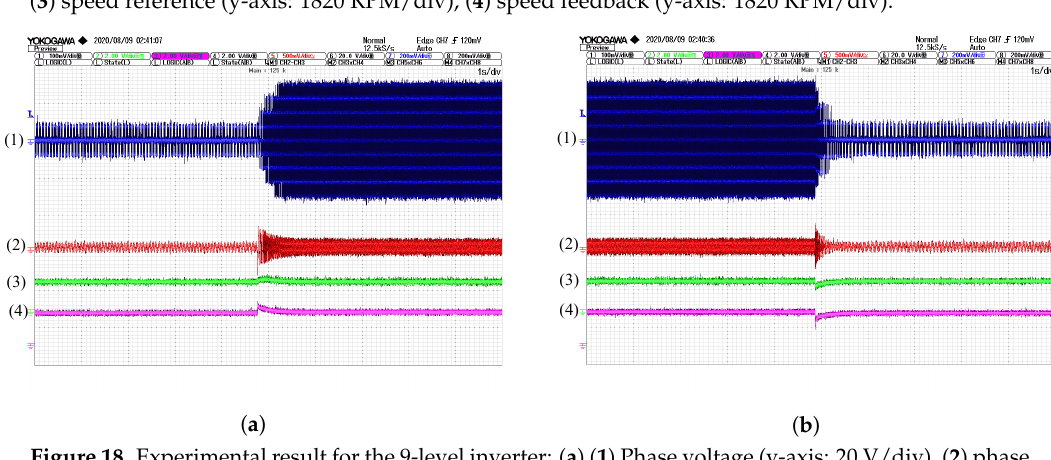
Figure 18. Experimental result for the 9-level inverter: ( a ) ( 1 ) Phase voltage (y-axis: 20 V/div), ( 2 ) phase current (y-axis: 5 A/div), ( 3 ) i d (y-axis: A/div), ( 4 ) i q (y-axis: A/div). ( b ) ( 1 ) Phase voltage (y-axis: 20 V/div), ( 2 ) phase current (y-axis: 5 A/div), ( 3 ) i d (y-axis: A/div), ( 4 ) i q (y-axis: A/div).